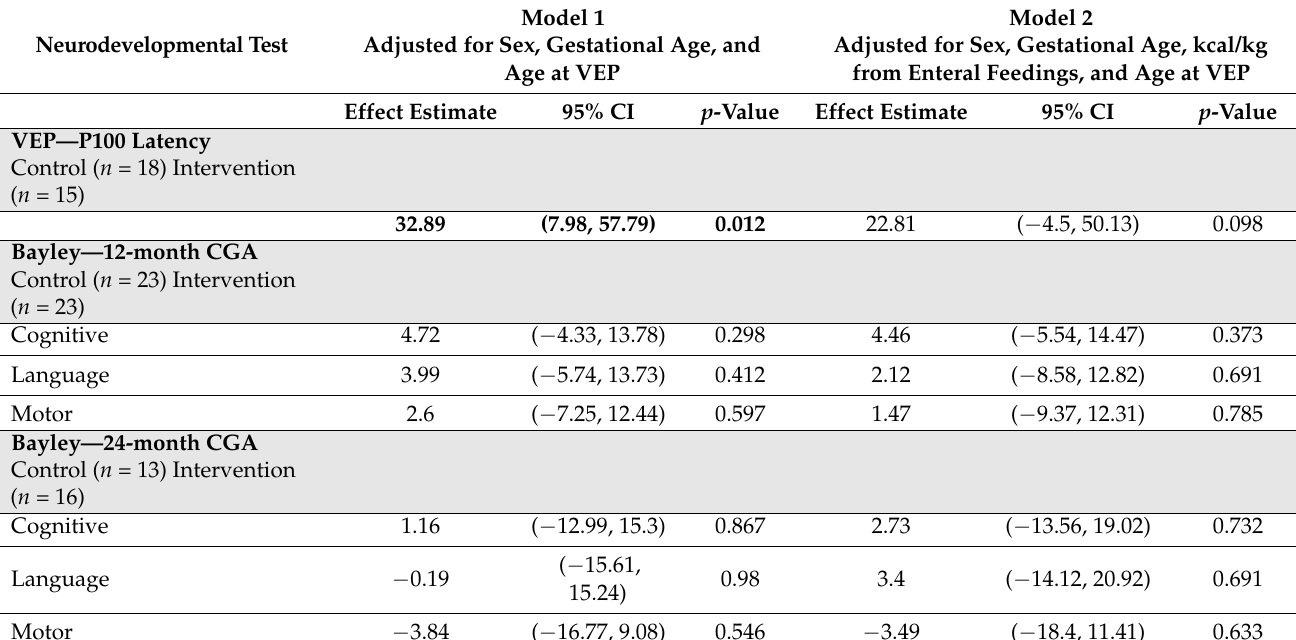
Table 4. Neurodevelopmental outcomes by randomization group—multivariable adjusted models.